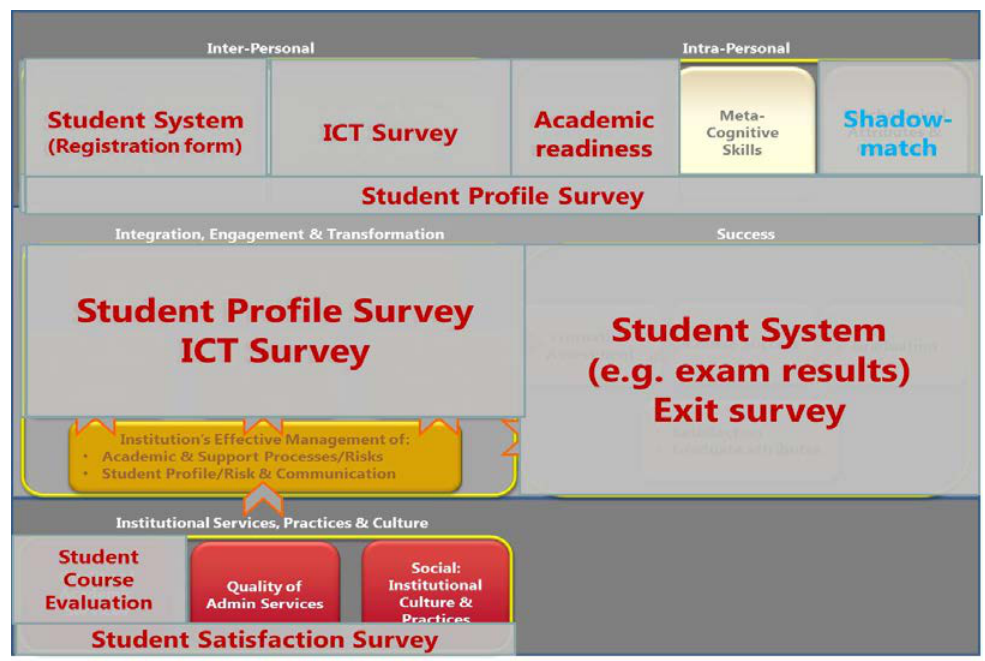
Figure 3 . Instruments and data sources currently employed to measure the elements of the student success